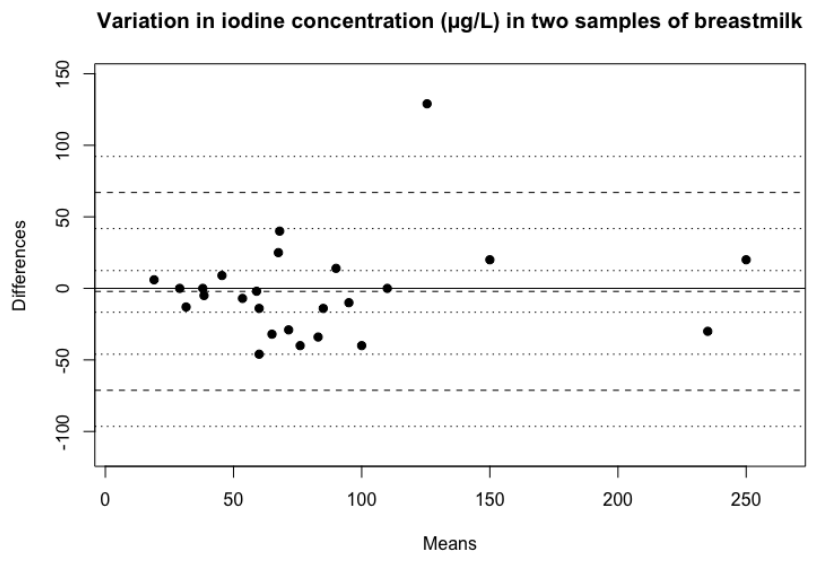
Figure 3. Variation in iodine concentration between two spot samples of breastmilk, including observed average agreement and 95% confidence intervals. y = 0 is the line of perfect average agreement.